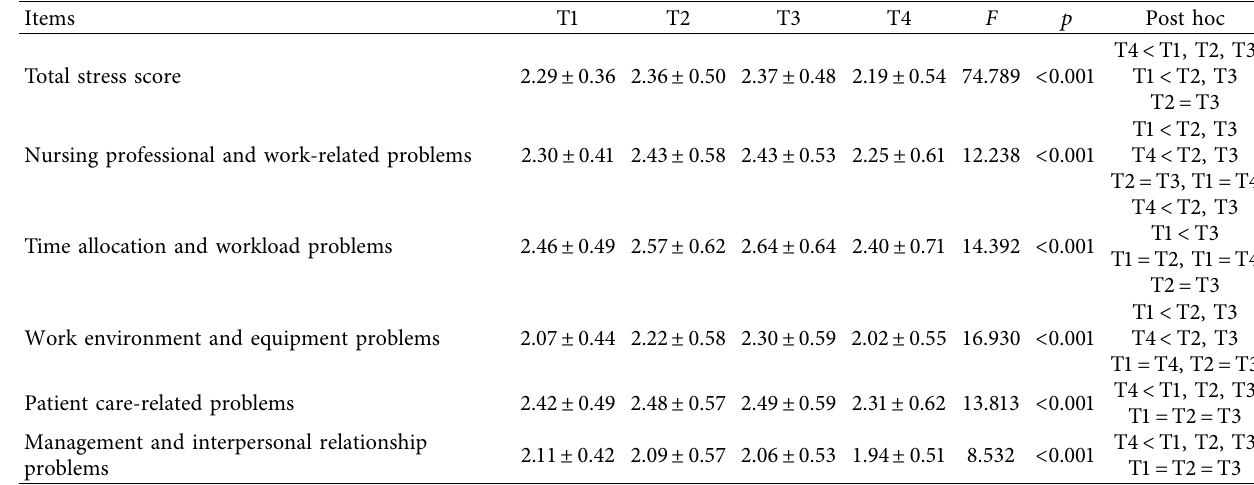
Table 1: Comparison of the stress of the survey respondents in diferent stages.